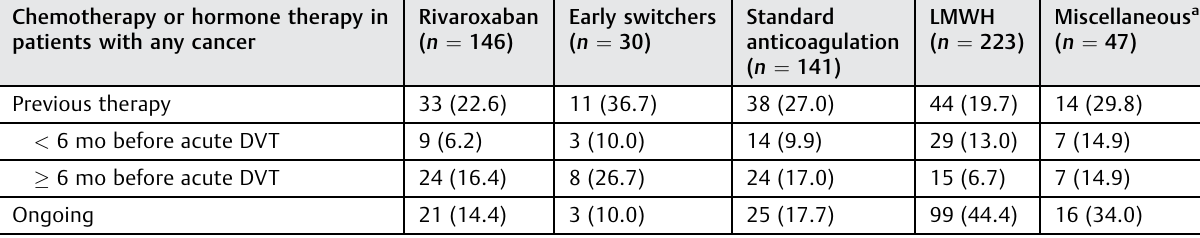
Table 5 Chemotherapy and hormone therapy in patients with any cancer Chemotherapy or hormone therapy in patients with any cancer